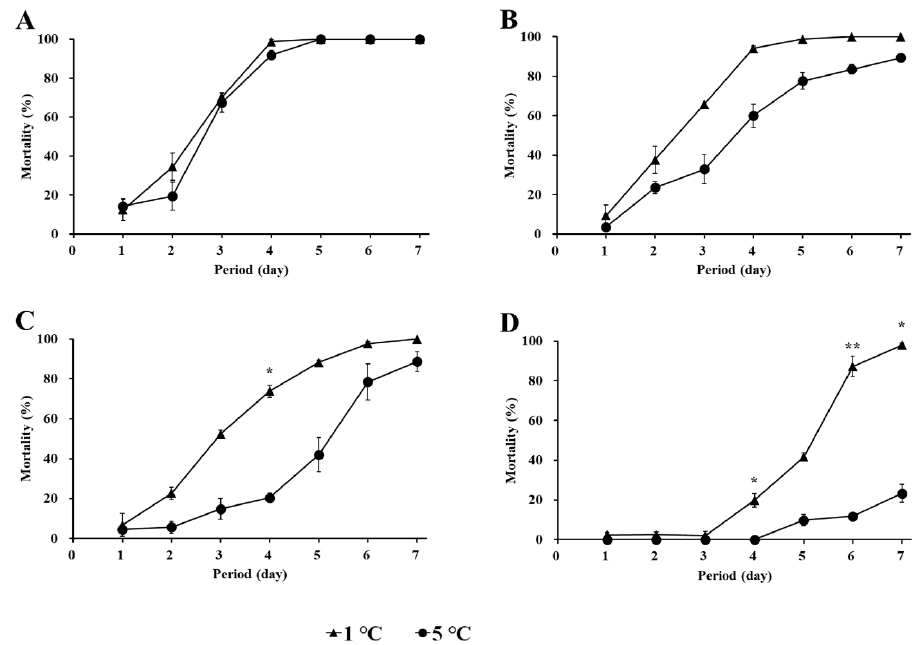
Figure 1. Effects of cold temperatures (1 °C and 5 °C) by exposure time on the control of each D. suzukii developmental stage. ( A ): eggs; ( B ): larvae; ( C ): pupae; ( D ): adults. * p < 0.001; ** p < 0.0001.